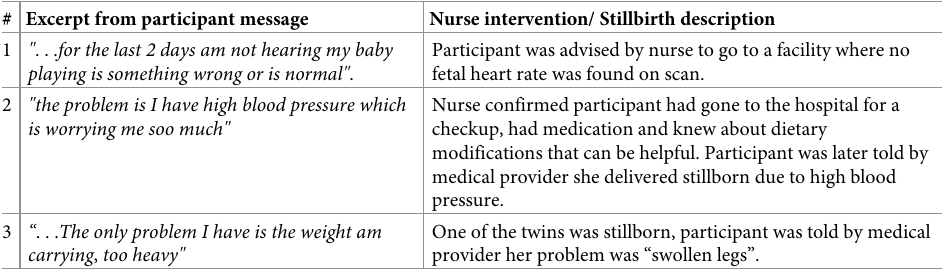
Table 4. Description of SMS interactions describing concerning pregnancy symptoms within 1 week of